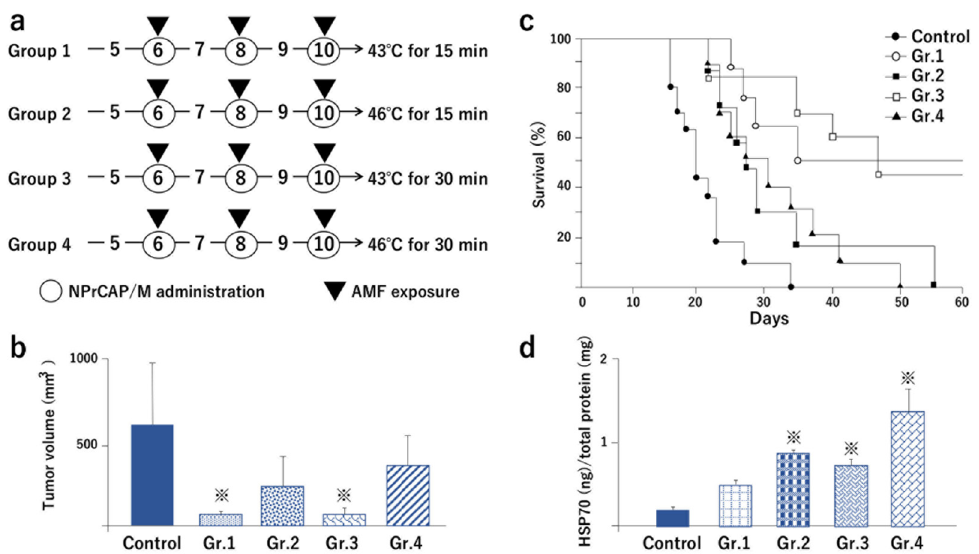
Figure 8. Schedule and conditions of magnetic hyperthermia using NPrCAP/M in treatment of primary B16F1 melanoma-bearing mice and results for second, re-challenge tumor volumes and survival of mice, as well as HSP expression in treated primary tumors. ( a ) Schedule and conditions of NPrCAP/M administration and AMF exposure for Groups 1, 2, 3, and 4 of mice with primary melanoma transplants. Control is the same as described in Figure 7a. ( b ) Tumor volumes on day 14 after re-challenge with B16F1 cells according to the protocol for primary tumor removal and re-challenge described in Figure 7b. ( c ) Kaplan–Meier survival curves up to 60 days after re-challenge. ( d ) Amounts of HSP70 in primary tumors 24 h after the first treatment of magnetic hyperthermia. ※ p < 0.05 versus control. Modified from